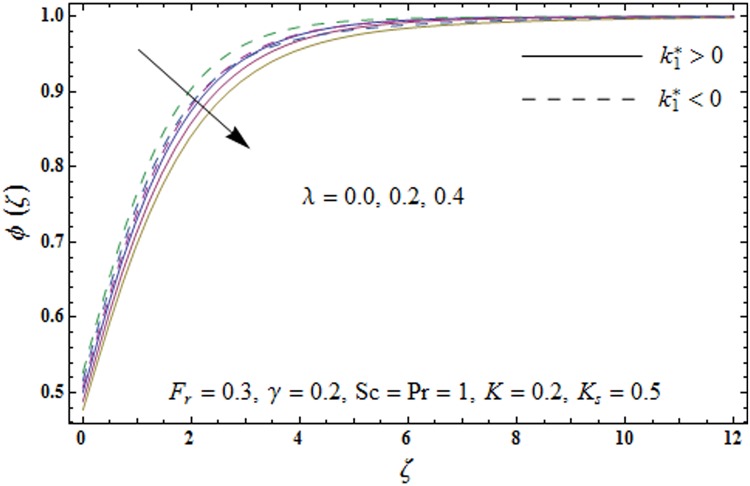
Plots of concentration field ϕ(ζ) for porosity parameter λ.